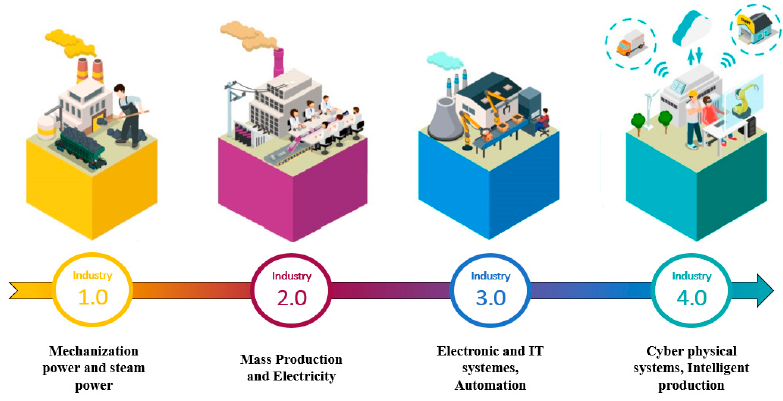
Figure 1. The four industrial revolutions.